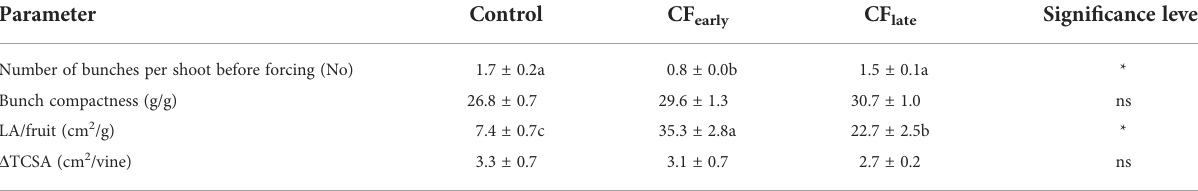
TABLE 2 Effects of crop forcing on number of bunches per shoot before forcing (before fruit thinning and shoot removal for the Control treatment), bunch compactness at harvest, LA/fruit ratio and TSCA in